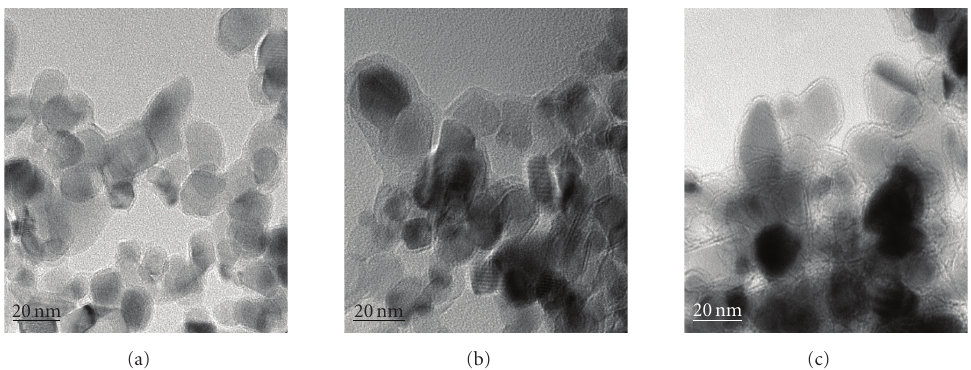
Figure 3: Transmission electron micrographs of granules of the di ff erent TiO 2 /ZnPc composites: (a) 1% ZnPc, (b) 2.5% ZnPc, and (c) 5% ZnPc.